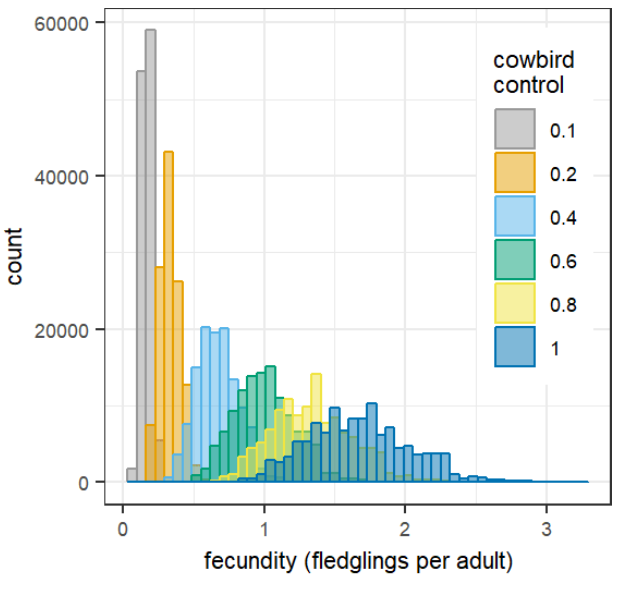
Fig. 3 . Frequency distributions of model fecundity values under different levels of simulated Brown-headed Cowbird impact. A cowbird control level of 1.0 indicates full control of cowbird parasitism and no impact on fecundity. A cowbird control level of 0.1 indicates extremely high levels of Brown-headed Cowbird parasitism and a heavy impact on Least Bell’s Vireo